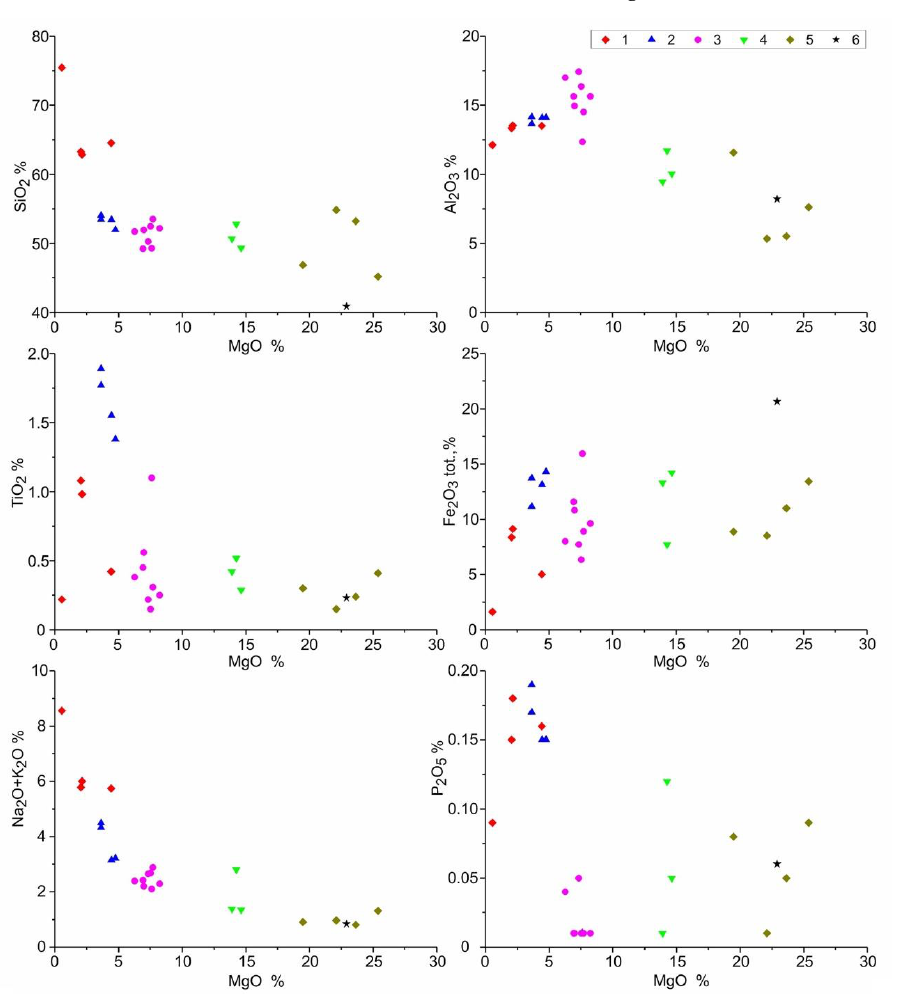
Figure 16. Petrochemical diagrams of MgO oxides for rocks of the Dyke complex. 1: Microgranites; Groups of mafic dykes: 2: I group, 3: II group, 4: III group, 5: IV group; 6: harrisite.